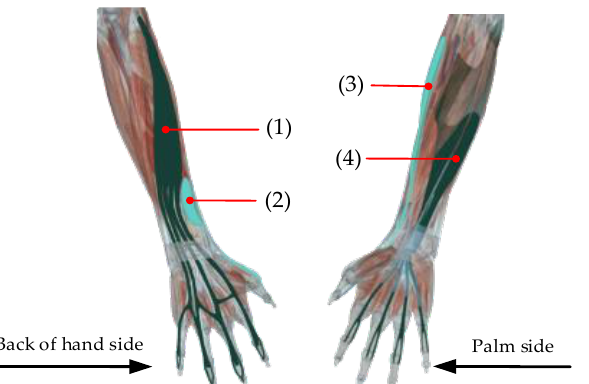
Figure 2. Position of surface electromyography (sEMG) signal acquisition sensors: (1) is the position of extensor digitorum (ED); (2) is position of extensor pollicis brevis (EPB); (3) is position of extensor carpi radius (ECR); and (4) is position of Flexor digitorum superficialis (FDS).